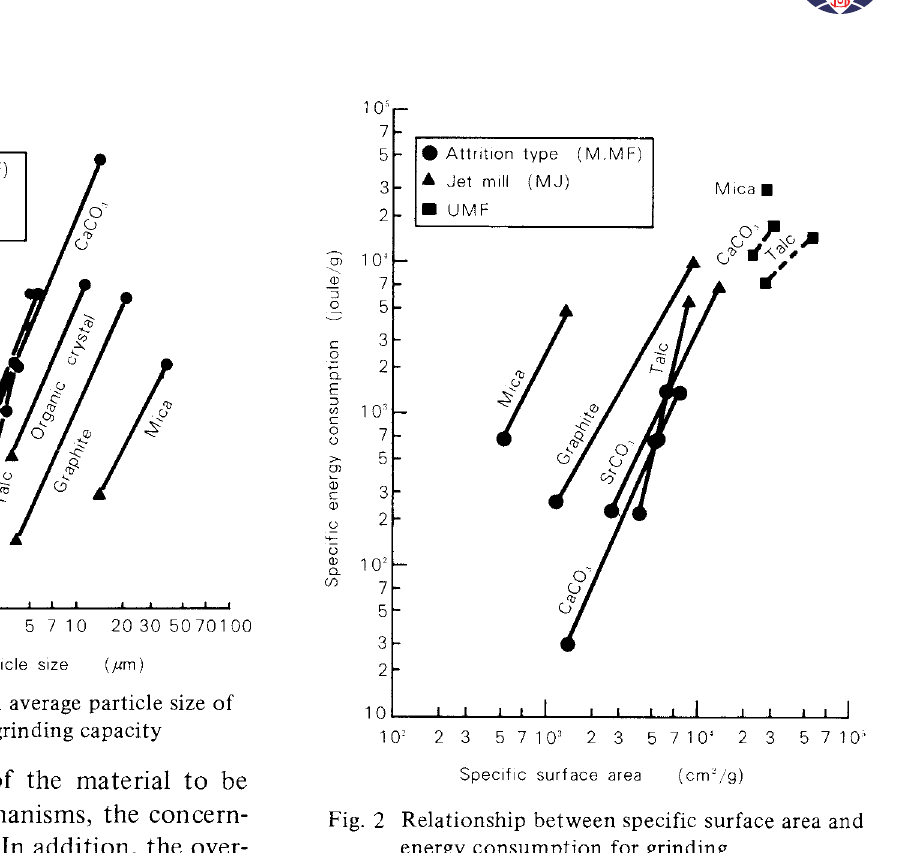
Fig. 2 Relationship between specific surface area and energy consumption for